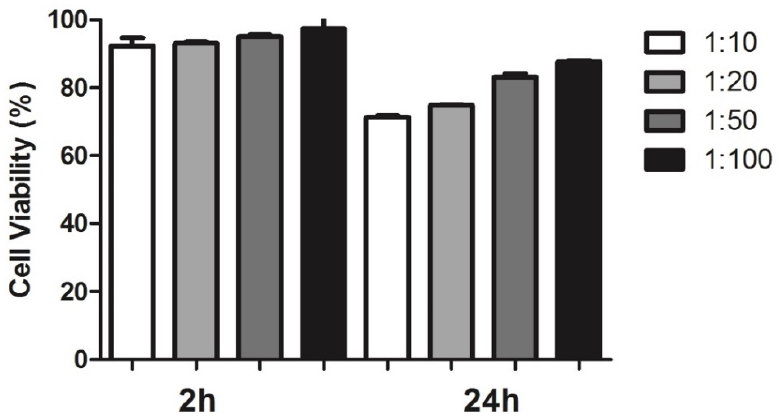
Figure 6. Viability of Caco-2 cells exposed to OE-ME (1:10 to 1:100), for 2 h.